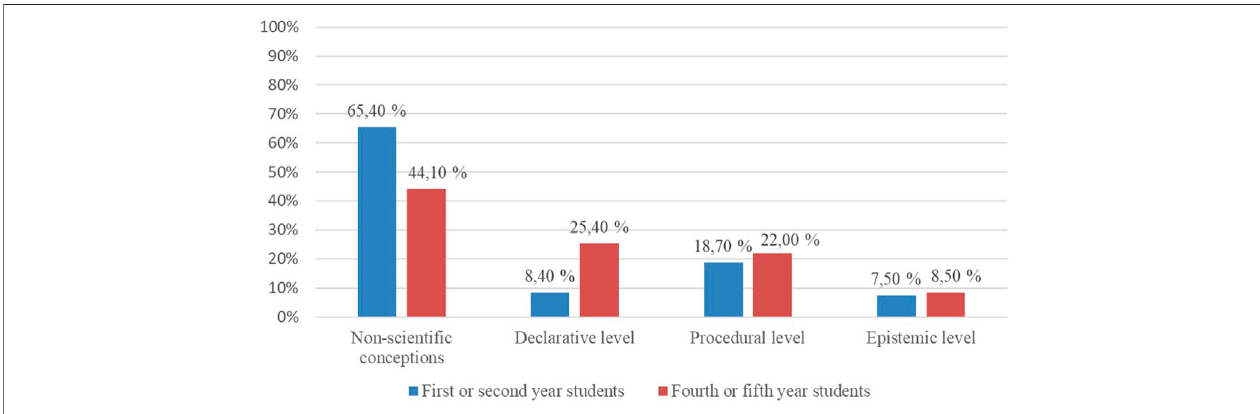
FIGURE 2 | Differences in conceptions of theory between fi rst and second year students and Master ’ s degree students.